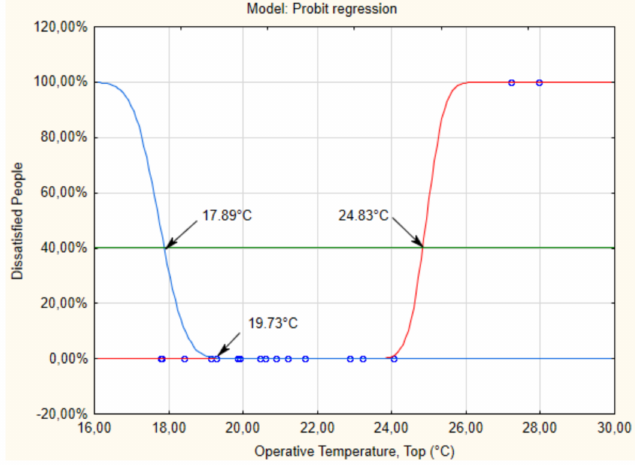
Figure 12. Probit APD_3. With a cutoff equal to 40.02%, the comfort zone for APD_3 varies from 17.89 ◦ C to 24.83 ◦ C, with a neutral operative temperature of 19.73 ◦ C, being approximately 0.03% of dissatisfied. Table 10 summarizes the values for neutral operative temperature, thermal comfort zone and the range obtained from each